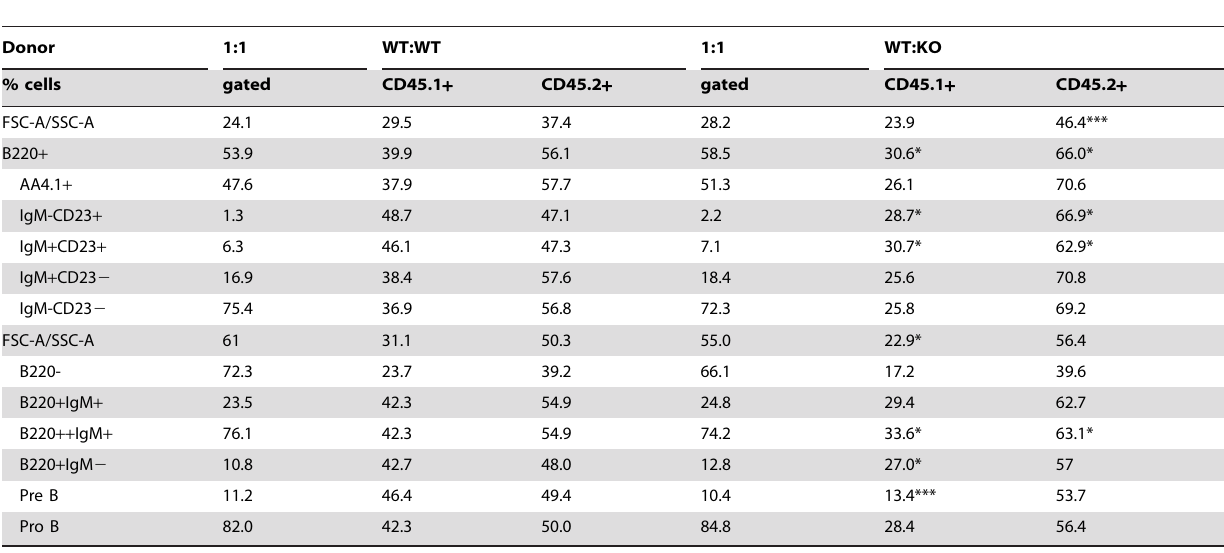
Table 1. FACS analysis of the B cell populations present in the bone marrow three months after competitive bone marrow